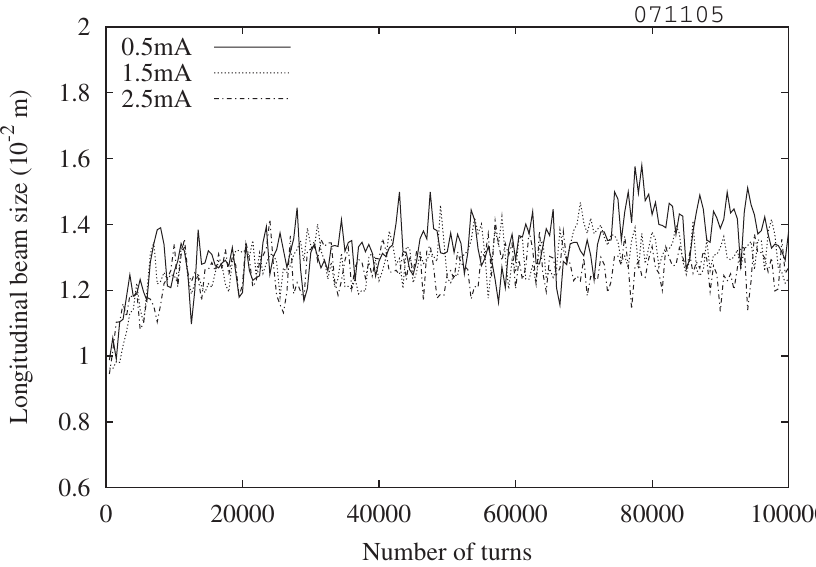
FIG. 3. Fitted longitudinal size of the weak beam distribution at the interaction point vs number of turns for several bunch currents.